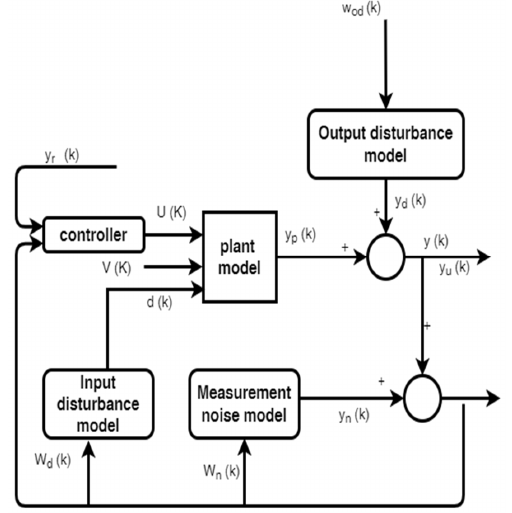
Figure A1. Conventional MPC configuration.